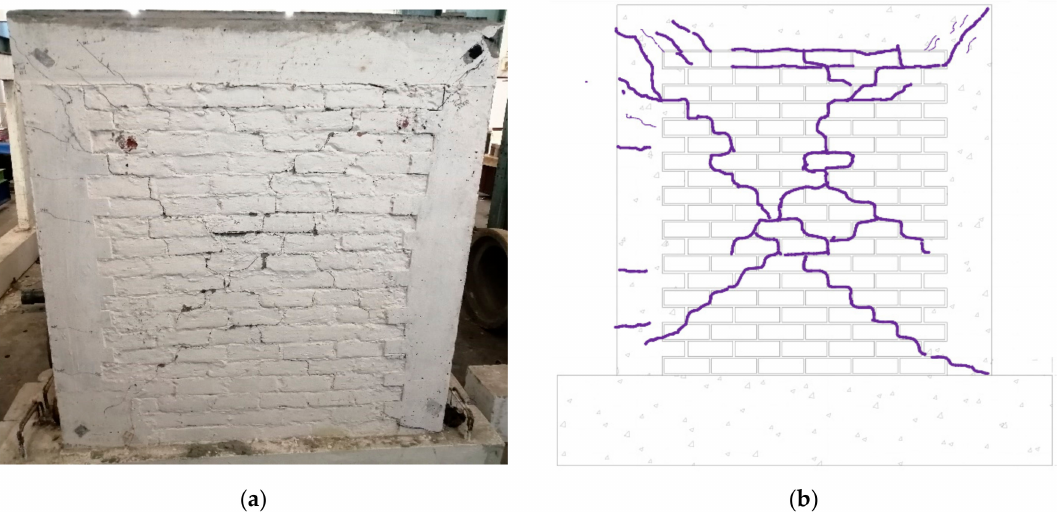
Figure 15. Crack pattern of GPC-CM ( a ) failure pattern of actual sample, ( b ) crack pattern diagram.